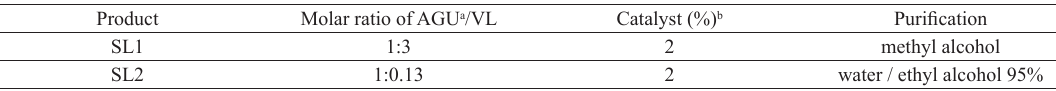
Table 1. Parameters of vinyl laurate transesterification reaction with